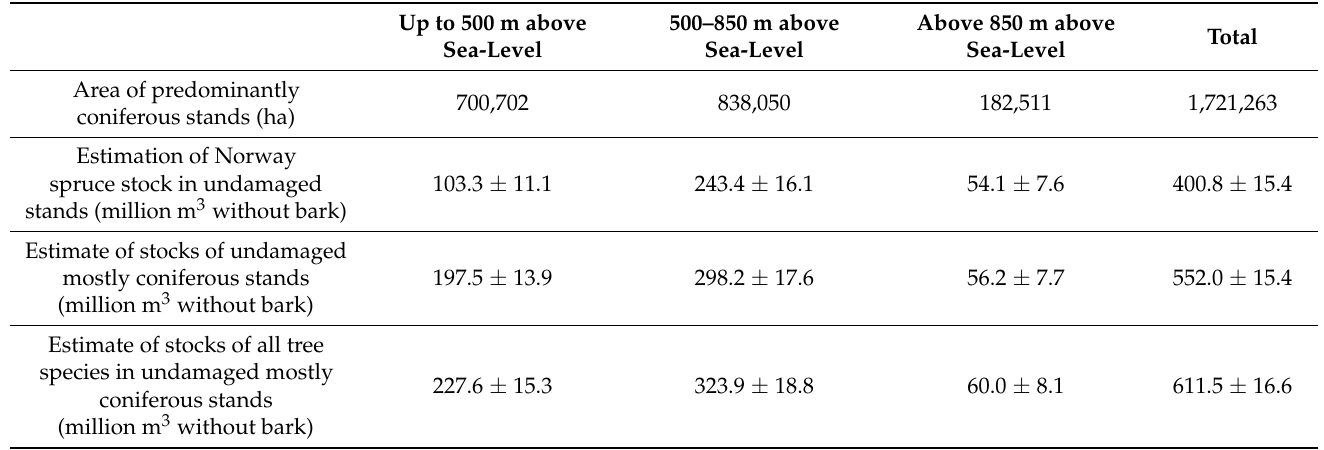
Table 2. Estimated stand areas and total wood stocks in predominantly coniferous stands in 2019 (million m 3 up to 7 cm without